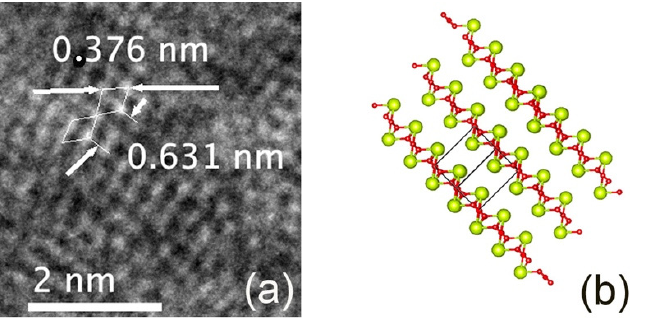
Figure 7. ( a ) TEM image of Ce 2 O 3 nanoceria obtained from the dissolution of S5NBCe glass ( b ) the schematic diagram of A-type Ce 2 O 3 .